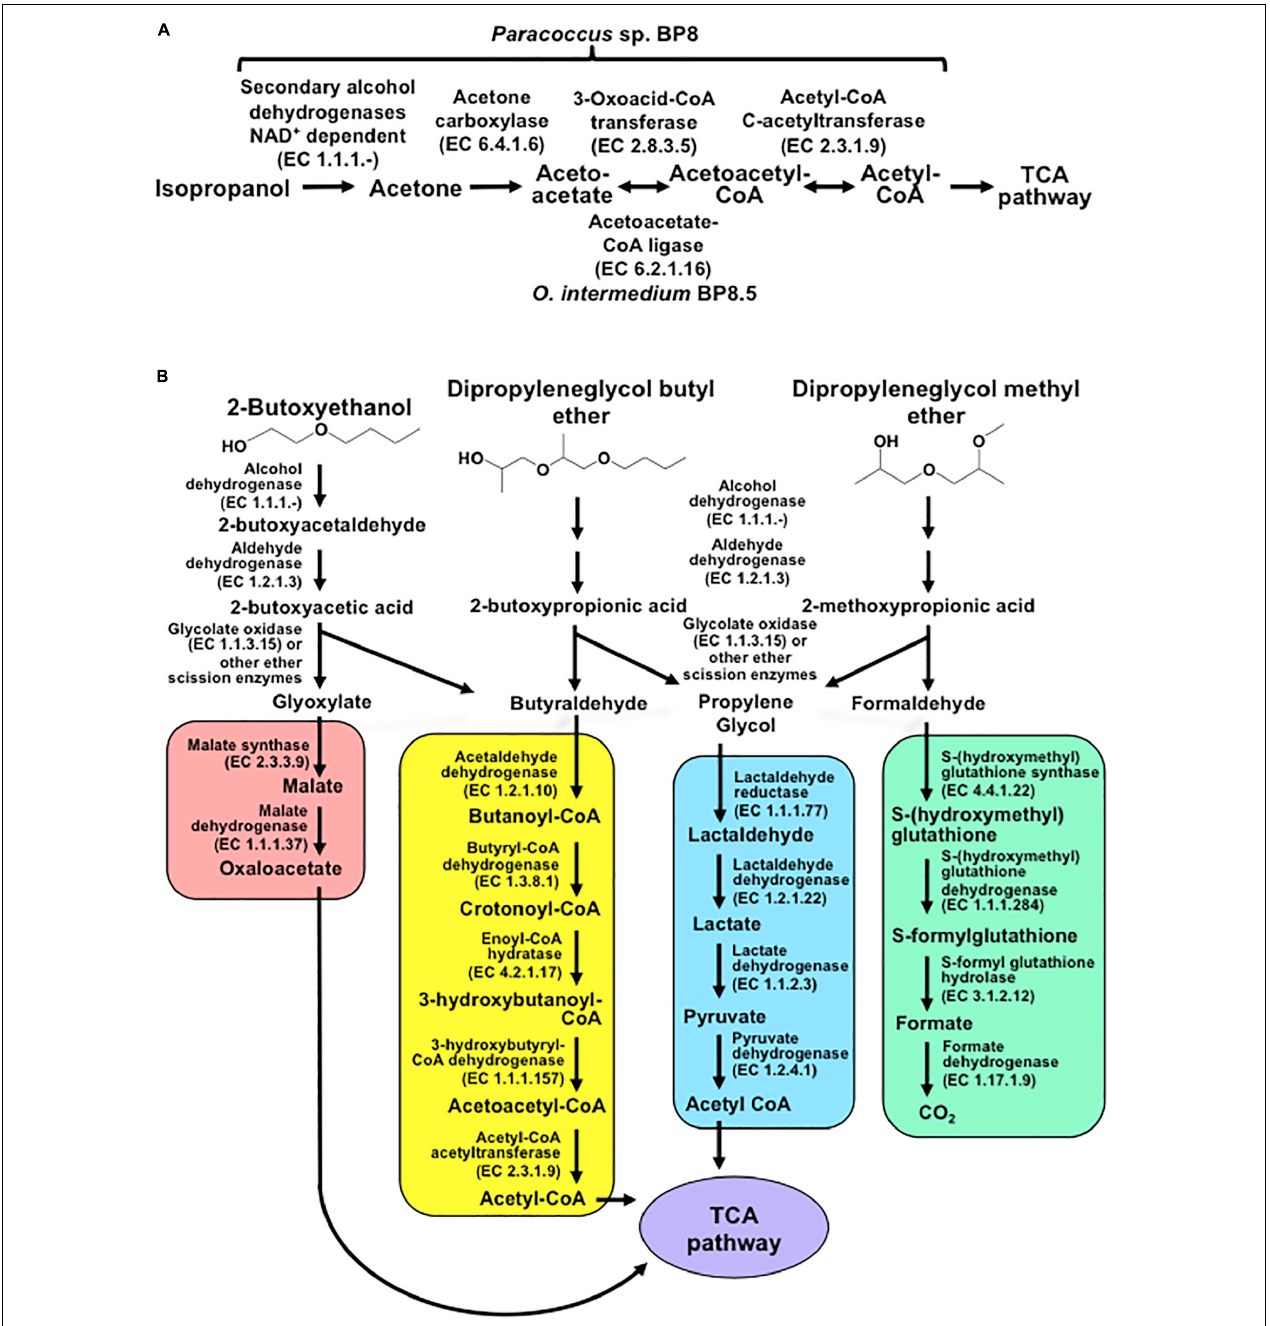
FIGURE 7 | Potential degradation pathways for isopropanol (A) and glycol ethers (B) encoded in the BP8 metagenome. (A) Paracoccus sp. BP8 genome encodes ADH enzymes that can oxidize IP to acetone, but genes encoding enzymes for the oxidative metabolism of acetone were not found. Instead, genes encoding the reductive transformation of acetone to acetyl CoA, acetone carboxylase, 3-oxoacid-CoA transferase and acetyl-CoA C-acetyltransferase, were identified. In O. intermedium BP8.5 genome, acetoacetate-CoA ligase, which performs the same reaction that 3-oxoacid-CoA transferase, is encoded. All the enzymes for the TCA pathway are encoded in the BP8 metagenome (see Table 3 ). (B) Subsequent oxidations of glycol ethers’ hydroxy terminal groups by PEG-DH and PEG-ALDH will produce 2-butoxyacetic acid from 2-BE, 2-butoxypropionic acid from DPGB and 2-methoxypropionic acid from DPGM. Subsequent cleavage of carboxylates’ ether bonds by ether scission enzymes such as glycolate oxidase, dye decoloring peroxidase, 4-methoxybenzoate monooxygenase and/or unspecific monooxygenase, would generate the metabolizable intermediaries glyoxylate, butyraldehyde, propylene glycol and formaldehyde. Glyoxylate would be funneled to the glyoxylate metabolism (red rectangle), butyraldehyde to the butanoate metabolism (yellow rectangle), propylene glycol to the pyruvate metabolism (blue rectangle), and formaldehyde to the formate metabolism (green rectangle). Pathways for glyoxylate, butanoate, pyruvate and formate metabolisms as well as the TCA pathway (purple ellipse) were fully reconstructed from the BP8 metagenome based on KEGG annotated genes, using KEGG Mapper.